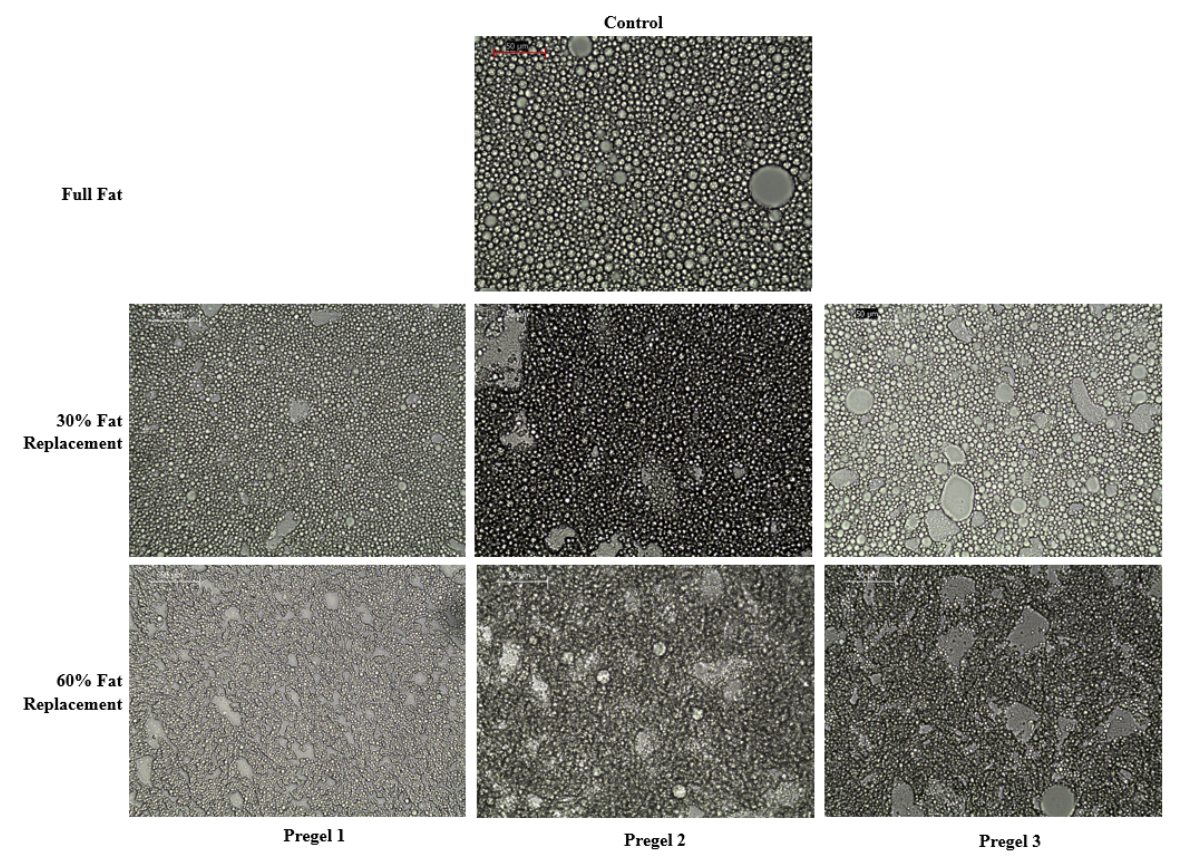
Figure 5. Optical microscopy images of mayonnaise like emulsions taken at 40 × magnification 24 h after their making. The scale bar indicates a size of 50 μ m.